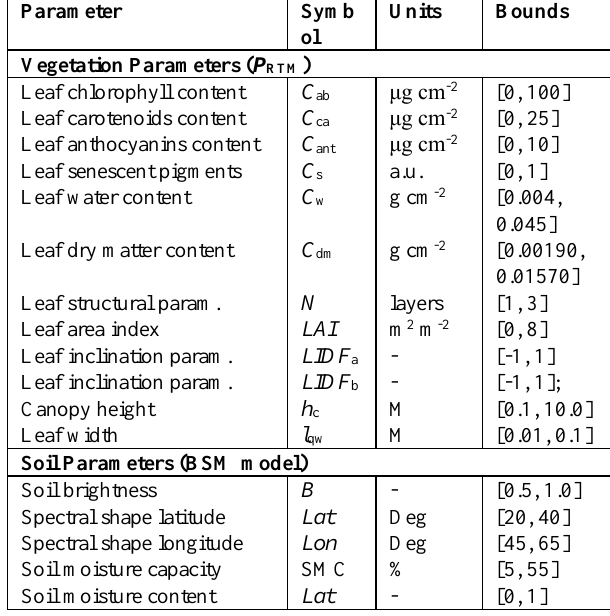
Table 2 . Retrieved SCOPE parameters.